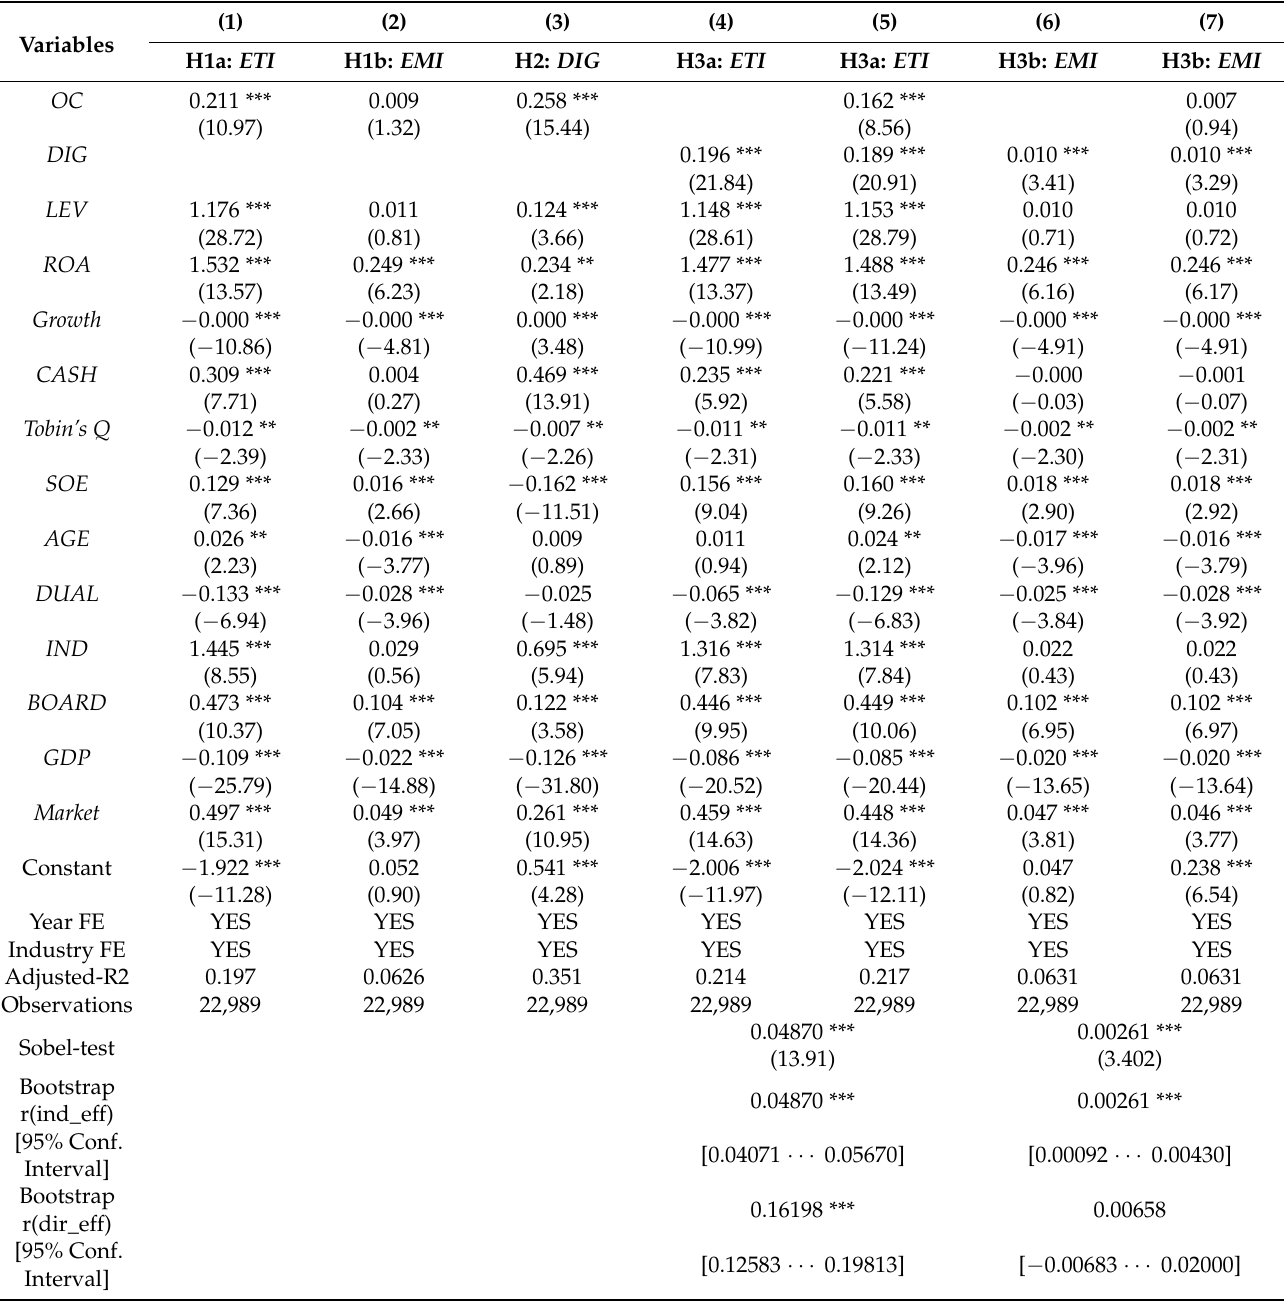
Table 4. The main empirical